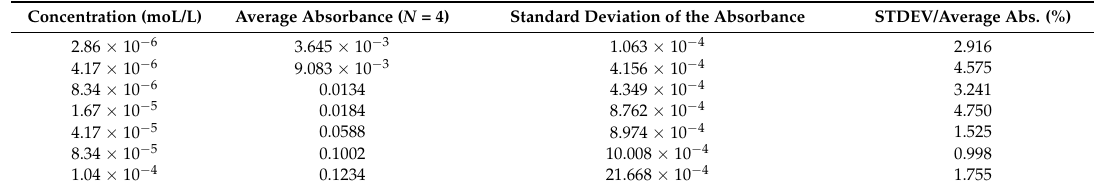
Table 3. The absorbance and average absorbance for nitrite solutions of different concentrations which were used to form the calibration curve.